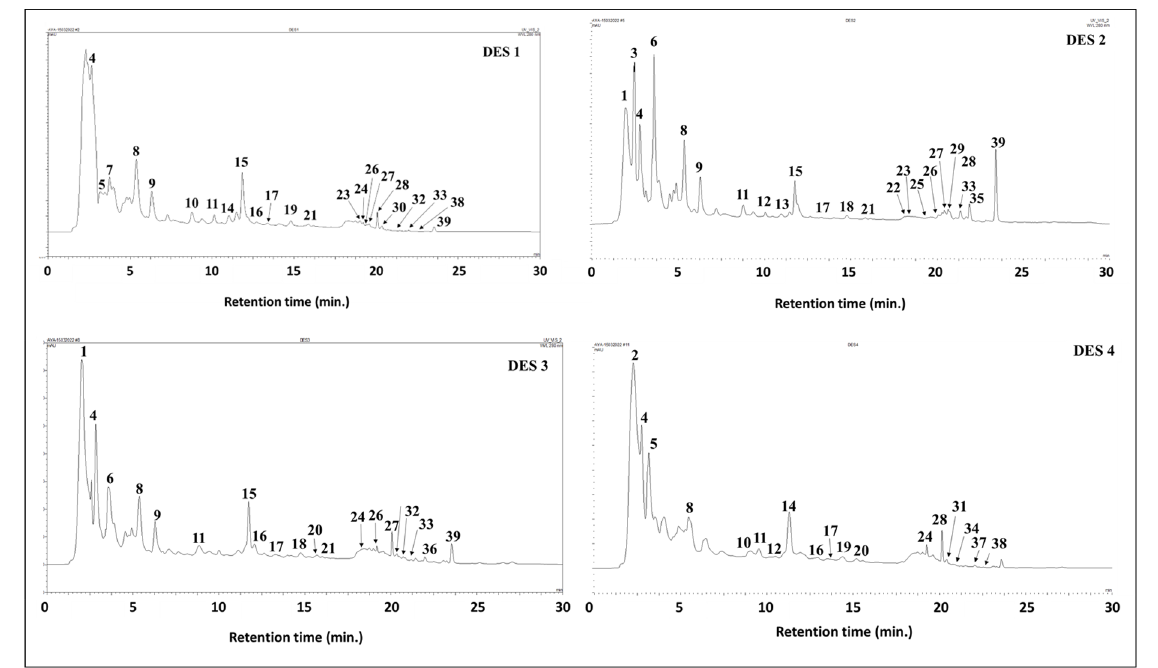
Figure 2. HPLC-DAD chromatograms at 280 nm of media after extraction (extracts in NaDESs). Table 8. Identification of molecules in tomato pomace extracts by HPLC–DAD (a.u.: area unit).